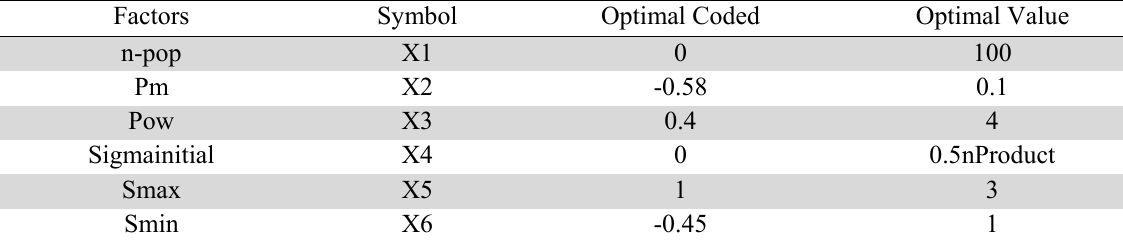
The input parameters for